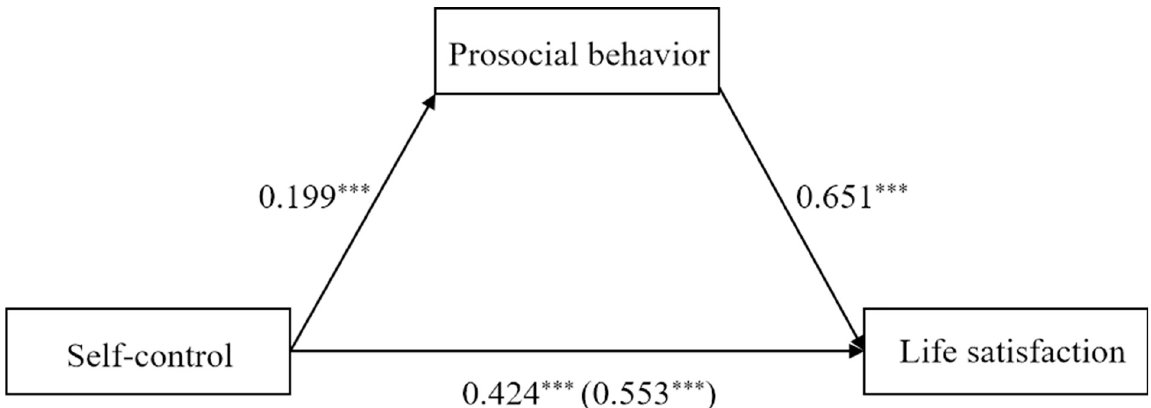
Fig 2. Mediation of prosocial behavior between self-control and life satisfaction in adolescents (sample 1). Note: ��� p < 0.001; value in parenthesis represents total effect.